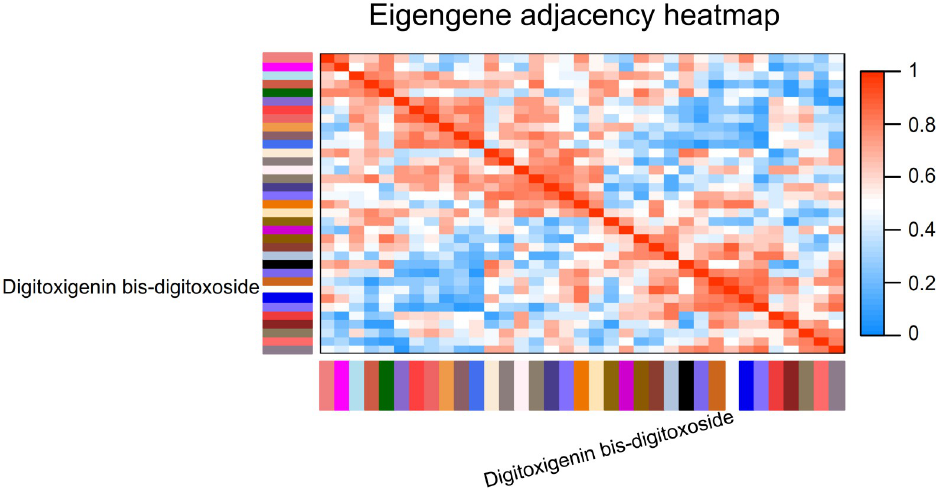
Fig 8. The heatmap plot of adjacencies in the eigengene network, including digitoxigenin bis-digitoxoside. Each row and column in the heatmap corresponds to one Module Eigengene (labeled by color) and or Digitoxigenin bis- digitoxoside. Low and high adjacencies (negative and positive correlations) are shown in blue and red. The connection strength (adjacency) between eigengenes I and J are defined as A